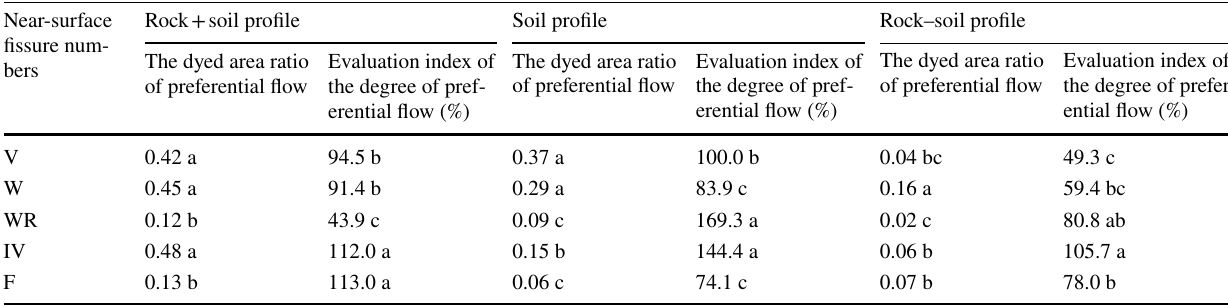
LSD (Least Significant Different) method was used for multiple comparisons. Different lowercase letters in the same column showed significant difference ( P < 0.05), while the same letters showed no significant difference ( P